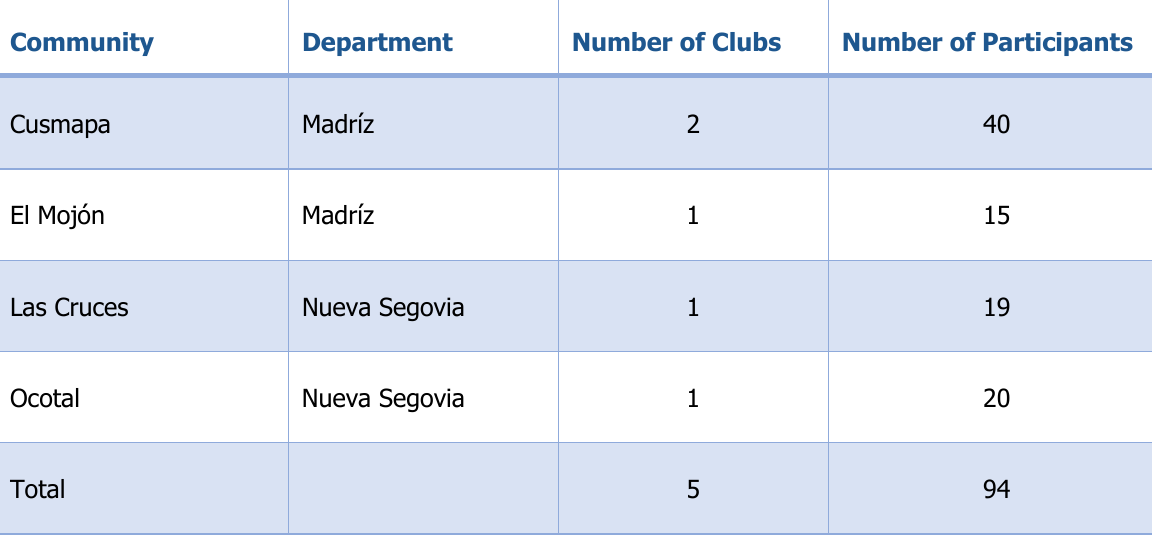
Table 1. Number of Clubs and Participants from Study Areas